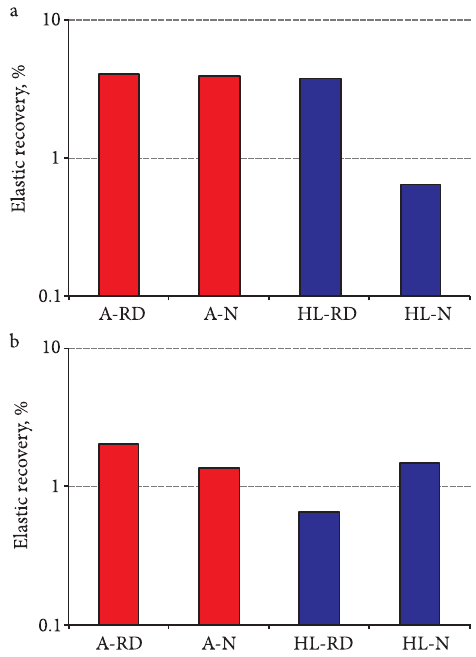
Fig. 8. Test results of the creep compliance extracted bitumen according to MSCR procedure: a – Jnr 100 Pa; b – 3200 Pa